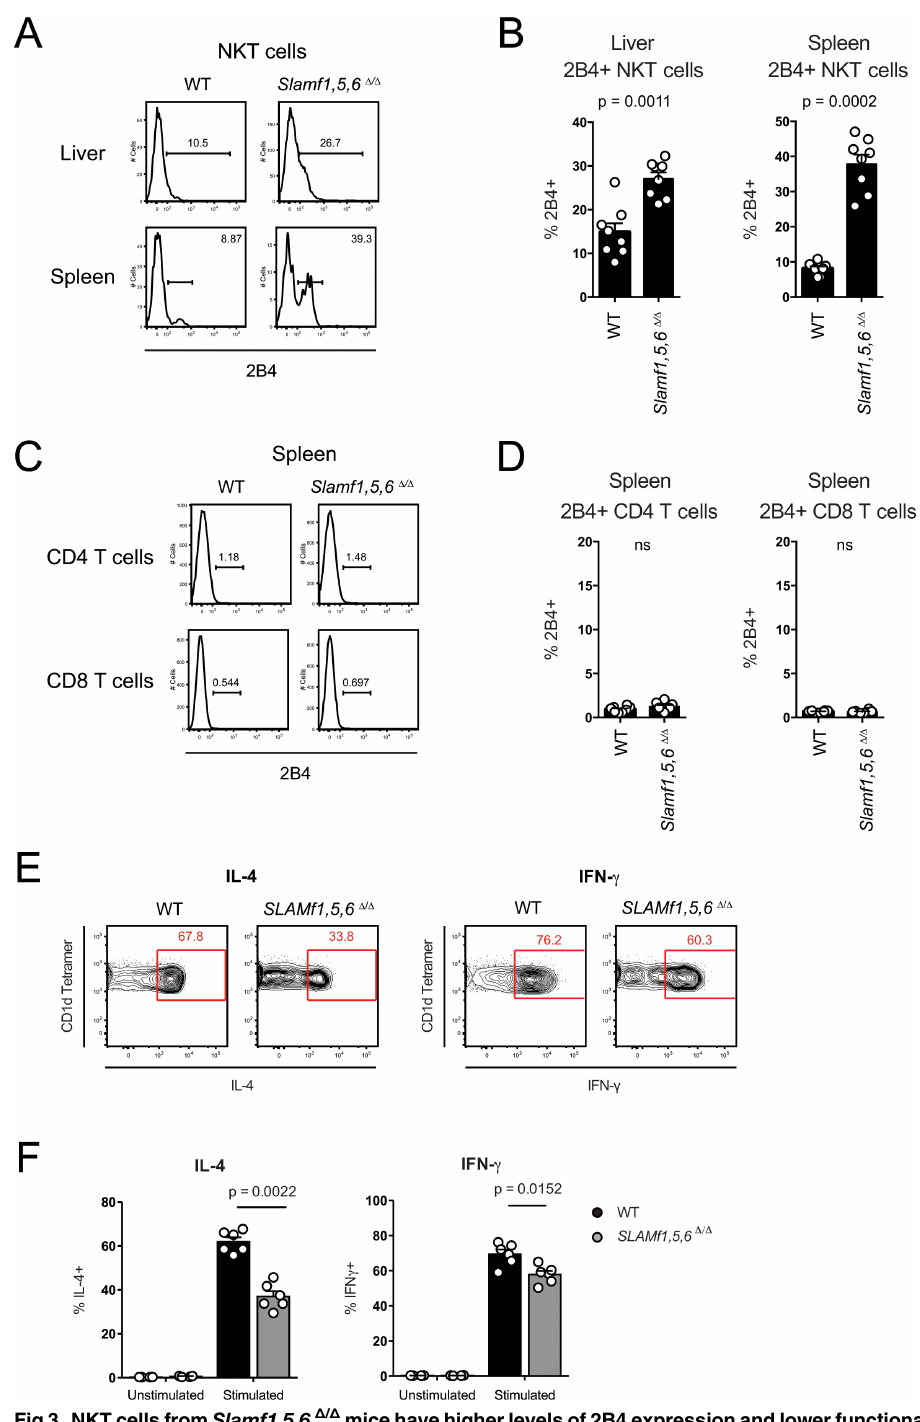
Fig 3. NKT cells from Slamf1 , 5 , 6 Δ / Δ mice have higher levels of 2B4 expression and lower functional secretion of cytokines. (A) Histograms and (B) graphs of 2B4 surface expression on B220 - CD3 + CD1d Tetramer + NKT cells in spleens and livers of WT and Slamf1 , 5 , 6 Δ / Δ mice. (C) Histograms and (D) graphs of 2B4 surface expression on splenic CD4 and CD8 T cells in WT and Slamf1 , 5 , 6 Δ / Δ mice. (A-D) Data shows two independent experiments, with 4 mice per group. (E) Flow cytometry plots of representative WT and Slamf1 , 5 , 6 Δ / Δ NKT cells (gated on B220 - CD3 int CD1d Tetramer + cells) after in vivo stimulation with α -GalCer for 45 minutes. Expression of IL-4 and IFN- γ are shown. (F) Frequencies of IL-4 and IFN- γ expression by NKT cells (gated on B220 - CD3 int CD1d Tetramer + cells). (E-F) Data represents two independent experiments, with 3 mice per